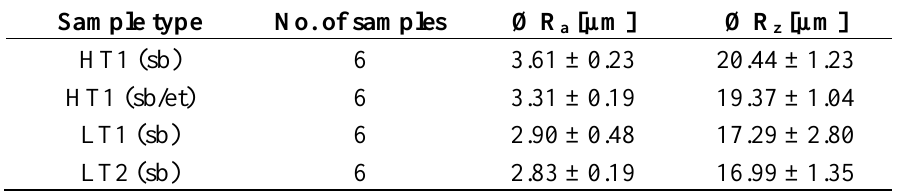
Table 4. Roughness parameters for modified TZP-A ceramic